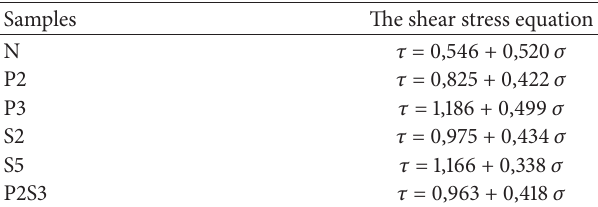
Table 5: The deformation ability values of the samples. Angles Samples